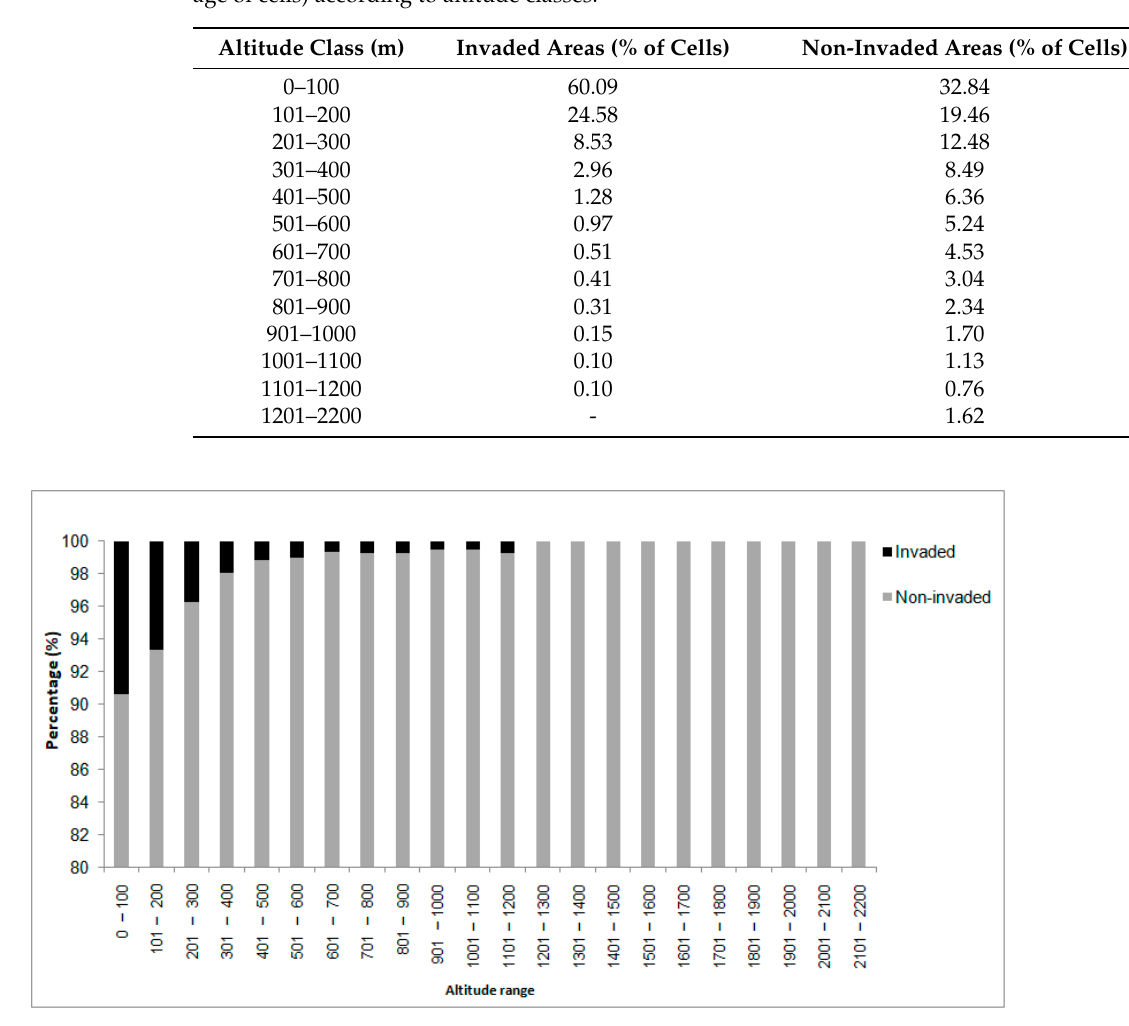
Figure 2. Percentage cover (%) at each class of the altitude range in the noninvaded areas (grey color) and the areas invaded (black) by Solanum elaeagnifolium in Greece. Note: the y -axis begins at 80%.